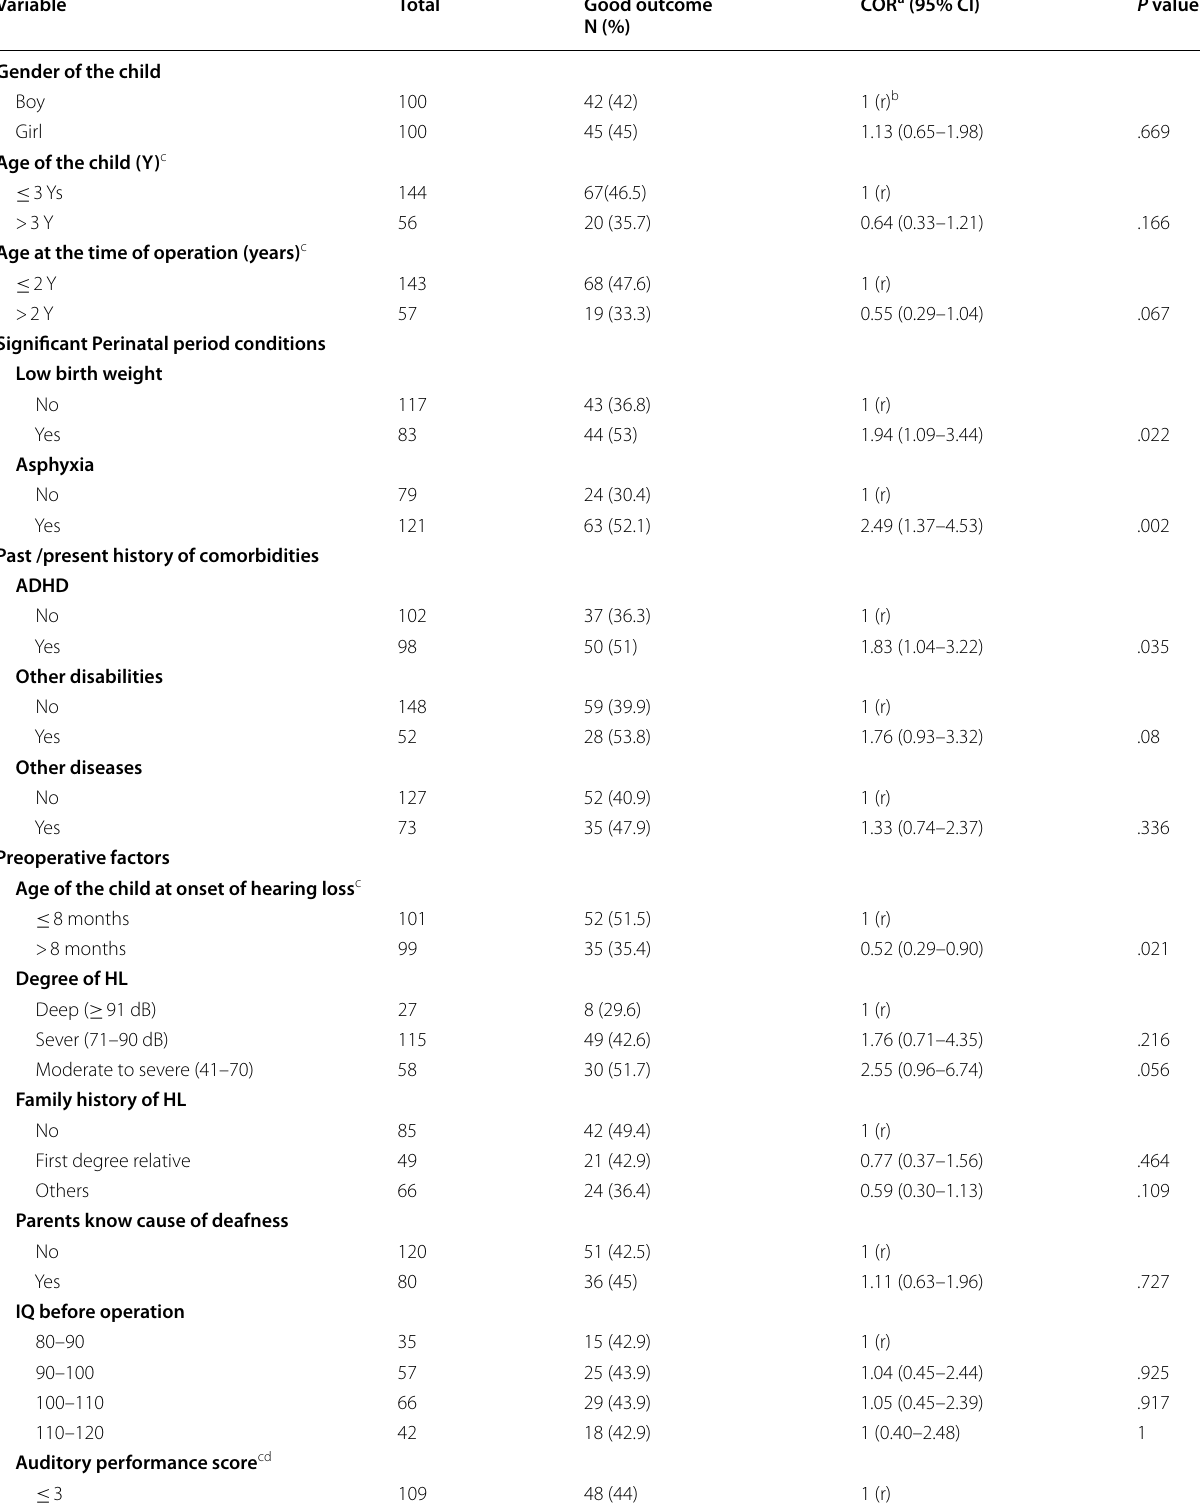
Table 2 The Association of clinical/medical history of children with moderate/severe hearing loss with the outcome of cochlear implant, Egypt,